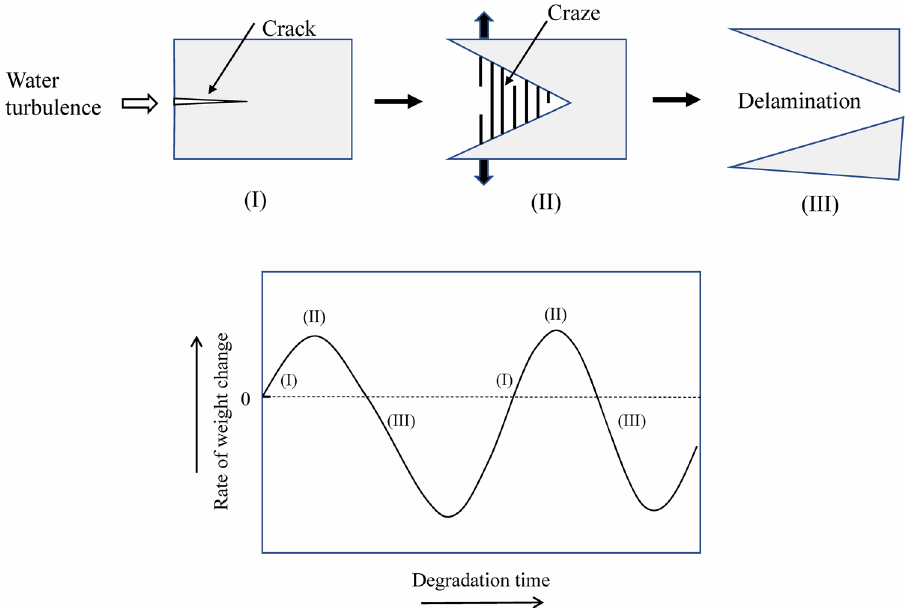
Fig. 6 ESC mechanism for PP